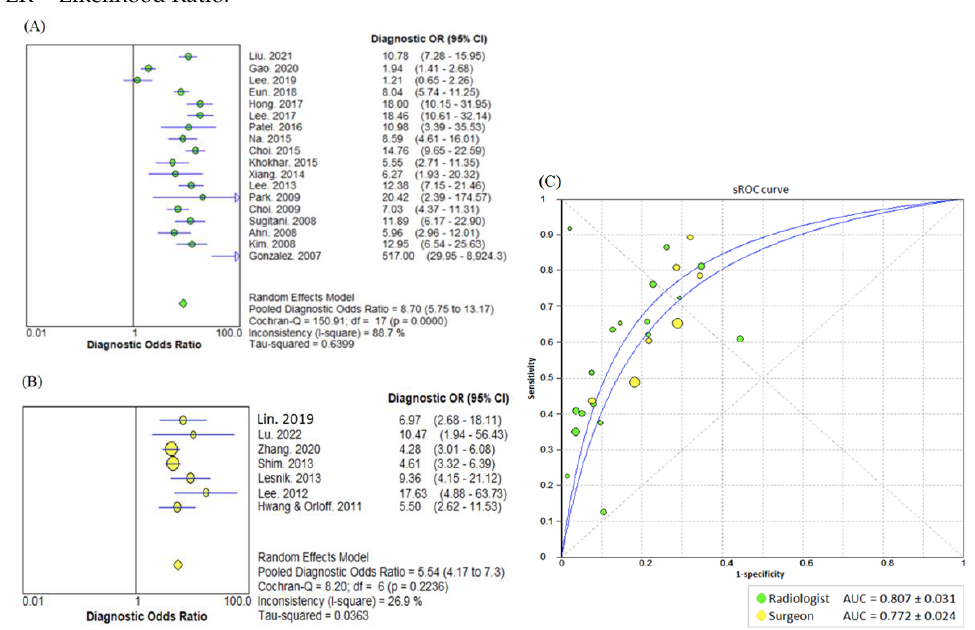
Figure 4. Comparison of diagnostic parameters of ultrasound performed by radiologists with those performed by non-radiologists. The ( A ) diagnostic odds ratio of radiologists [18,20,23 – 30,32,34 – 39], ( B ) diagnostic odds ratio of non-radiologists [13,19,21,22,31,33,41], and ( C ) summary receiver operating curve are presented. Summary receiver operating curve is presented as an area under the curve and standard error. Heterogeneity was assessed using Cochran-Q test and magnitude was estimated by the I-square value. OR = Odds Ratio; CI = Confidence Interval; AUC = area under the curve; sROC = summary receiver operating curve.